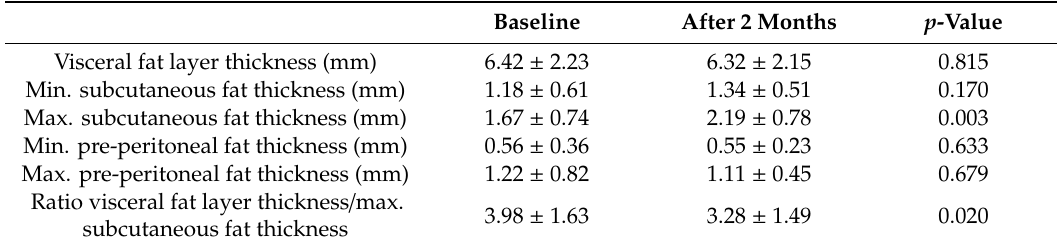
Table 3. E ff ect of EVOO with a high OC concentration on abdominal ultrasound